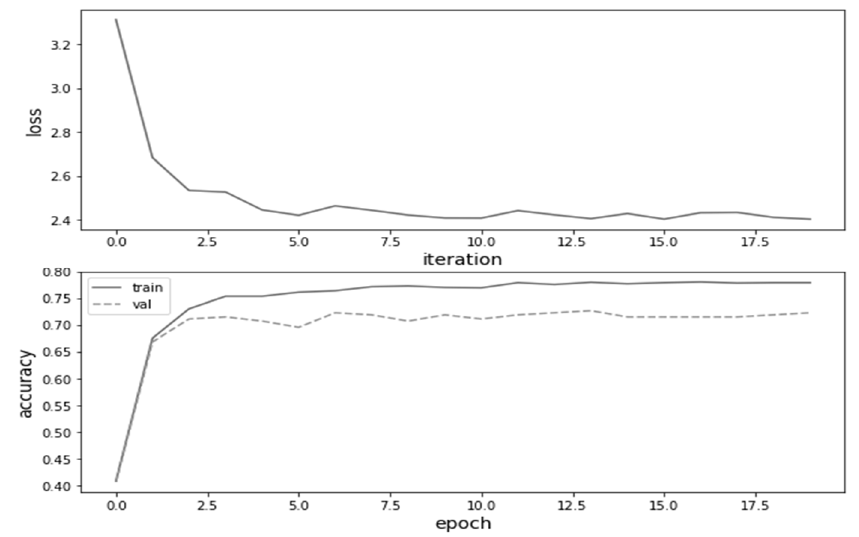
Figure 4. Loss and training plots.